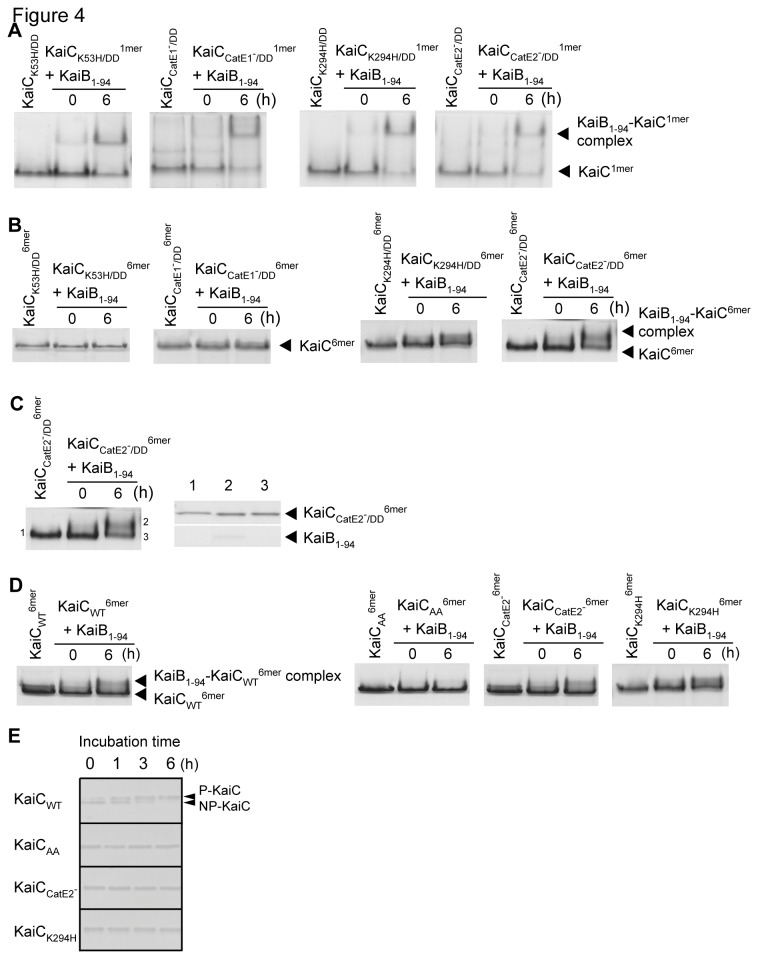
Effects of mutations in the ATPase motifs and phosphorylation sites of KaiC on formation of the KaiB1-94-KaiC6mer complex.A. Native PAGE gels of the reaction products of KaiC1mer with KaiB1-94. Reaction mixtures containing 15 μM KaiB1-94 and 5 μM KaiC1mer were incubated at 4 °C for the periods indicated. Other conditions were the same as described for Figure 1. B. Native PAGE gels of the reaction products of KaiC6mer with KaiB1-94. Reaction mixtures containing 5 μM KaiB1-94 and 1 μM KaiC6mer were incubated in the presence of Mg-ATP at 4 °C for the periods indicated. Other conditions were the same as described for Figure 1C. C. A typical 2D SDS-PAGE gel from the native-PAGE gel shown in Figure 4B. The protein bands were excised, and the proteins were extracted from them and subjected to SDS-PAGE. Other conditions were the same as described for Figure 1C. The bands 1 to 3 were the KaiCCatE2-/DD
6mer band (control), the upper band of the reaction products of KaiCCatE2-/DD
6mer with KaiB1-94 incubated at 4 °C for 6 h, and the lower band of the reaction products of KaiCCatE2-/DD
6mer with KaiB1-94 incubated similarly. D. Native PAGE gels of the reaction products of KaiC6mer with KaiB1-94. Reaction mixtures were incubated at 4 °C for the periods indicated. Other conditions were the same as described for Figure 4B expect that unphosphorylatable mutant KaiCs were used. E. SDS-PAGE gels showing no phosphorylation of KaiCAA
6mer, KaiCCatE2-6mer, and KaiCK294H
6mer. KaiCs6mer (0.5 μM) were incubated with Mg-ATP in the presence of 0.5 μM KaiA at 40 °C for the periods indicated and then subjected to SDS-PAGE. p-KaiC, the phosphorylated forms of KaiC; np-KaiC, the unphosphorylated form of KaiC. Other conditions were the same as described for Figure 3.